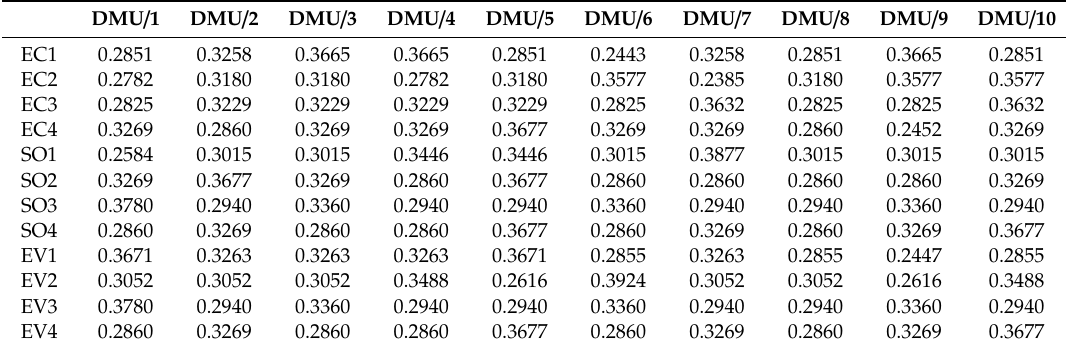
Table 7. Normalized